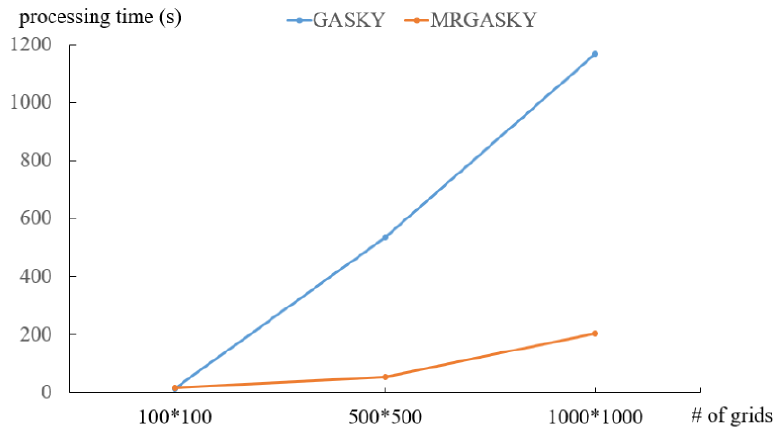
Figure 14. Processing Time of SYN_A2.